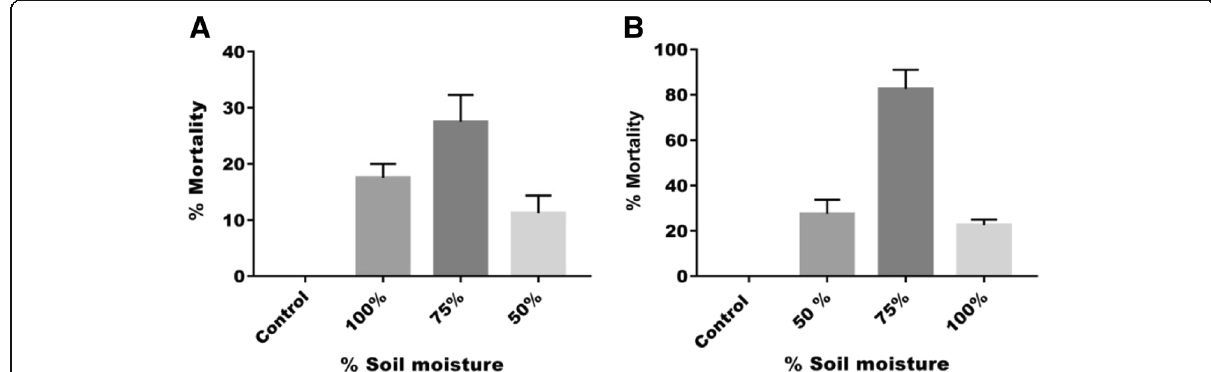
Fig. 5 Mean mortality (±SEM) of Ceratitis capitata pupae ( a ) and larvae ( b ) inoculated with Steinernema feltiae at a rate of 100 IJs/ml and maintained under different levels of soil